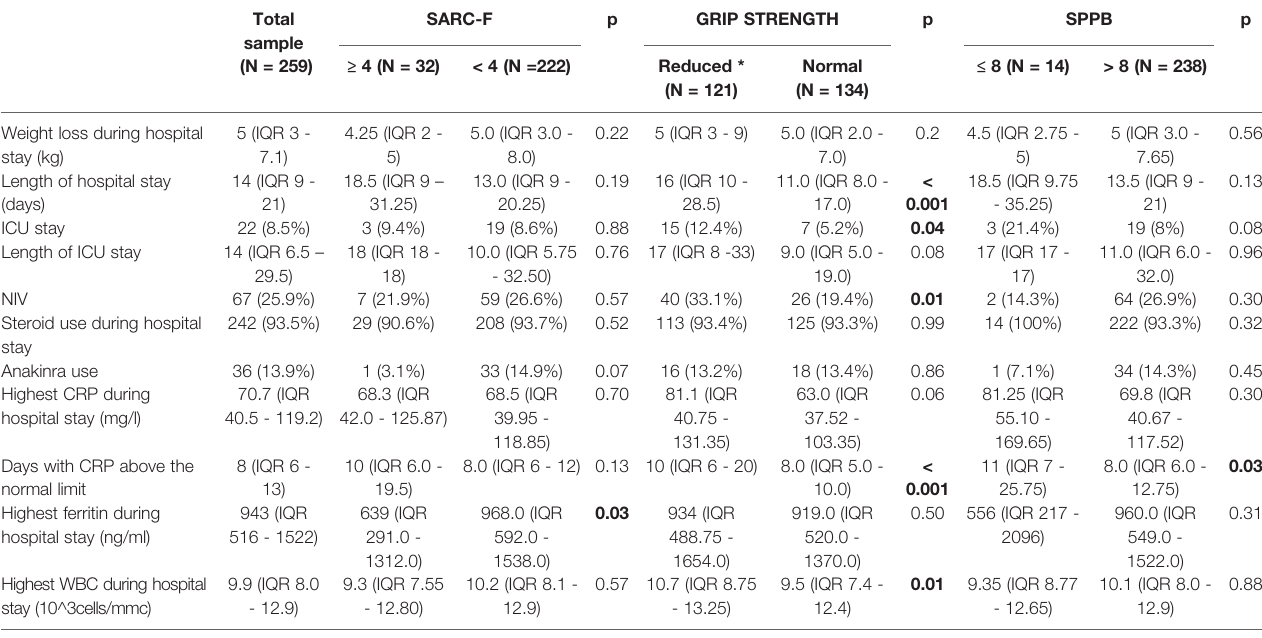
TABLE 2 | Main characteristics of the COVID-19 hospitalization of the study population and their comparison among groups with pathologic and normal values of a sarcopenia screening tool, muscle strength and